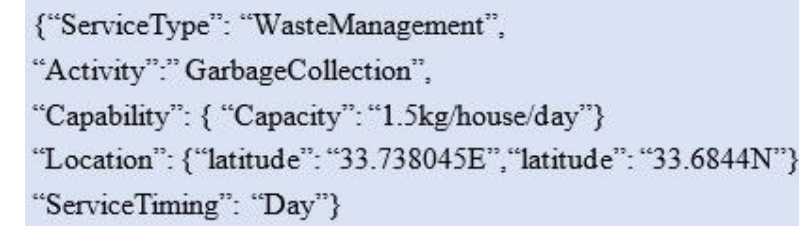
Figure 4. Modeling at service seeker